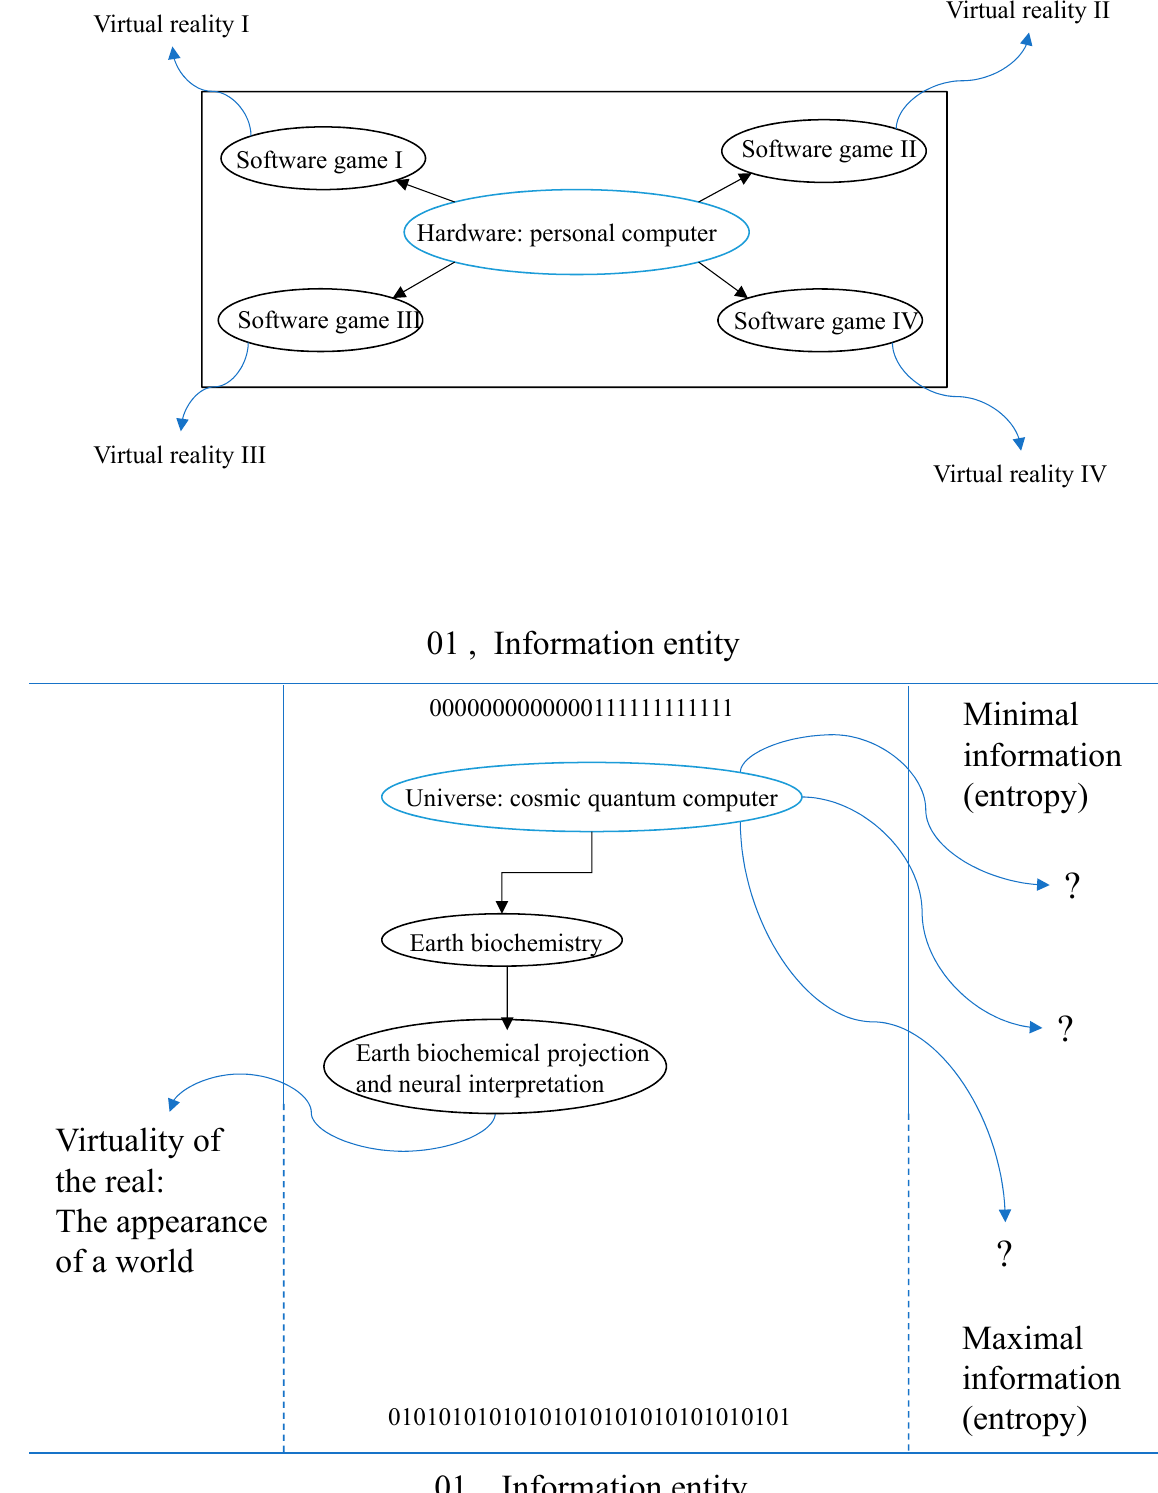
Figure A3. Virtual reality versus virtuality of the real.(Graphics Simon